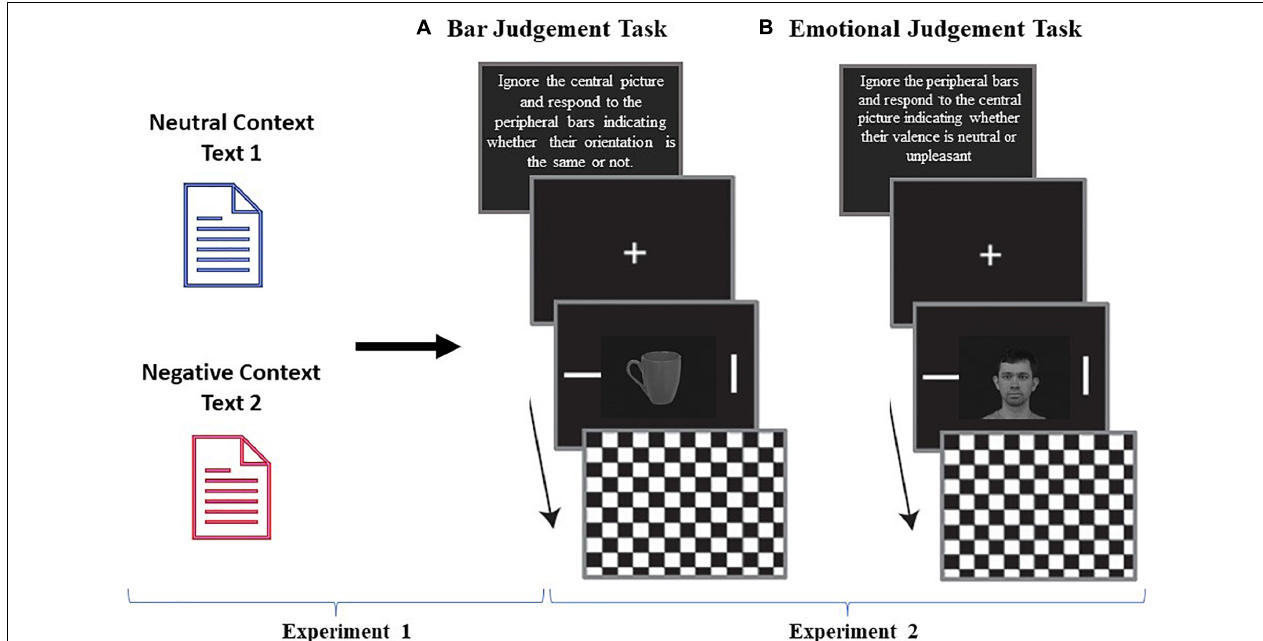
FIGURE 1 | Schematic representation of the sequence of events in each task. During the text rating task experiment, participants read a text and rated the text on a 1–9 scale in terms of valence and arousal (SAM). The subsequent behavioral experiment consisted of two judgment tasks: emotional judgment and bar orientation judgment. The central pictures could be neutral faces (45) or neutral objects (45) and were presented once in each task. Each trial began with a fixation cross that was presented for 1,500 ms, which was followed by a central picture and two peripheral bars that were presented for 200 ms. A checkerboard mask then appeared and remained on the screen until the participant gave a response or the maximum amount of allotted time (1,500 ms) passed. In the bar judgment task (A) , participants were instructed to ignore the task-irrelevant central pictures and to respond as quickly and accurately as possible regarding the orientation of the peripheral bars by indicating whether the orientation of the bars was the same. In the emotional judgment task (B) , participants were instructed to ignore the peripheral bars and respond if they judged the central picture as neutral or negative. The order of the type of task, bar judgment or emotional judgment was randomized across the subjects. Facial image is from Karolinska Directed Emotional Faces (KDEF) database number